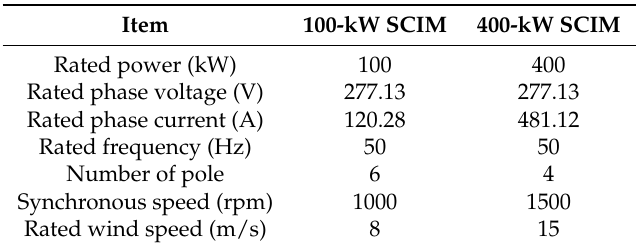
Table 1. Parameters of the squirrel-cage induction machines (SCIMs).